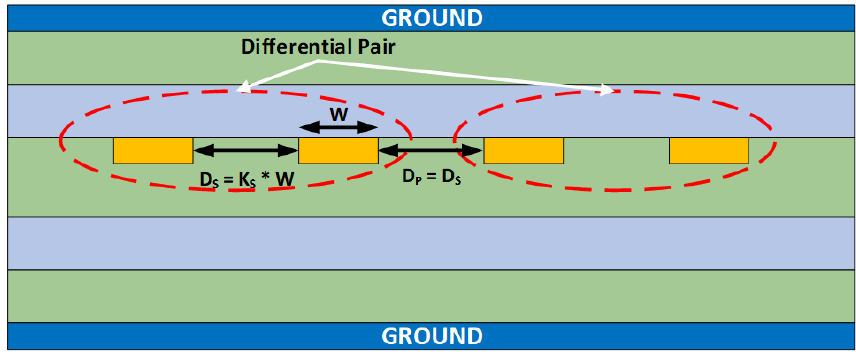
Figure 9. Stripline structure with differential